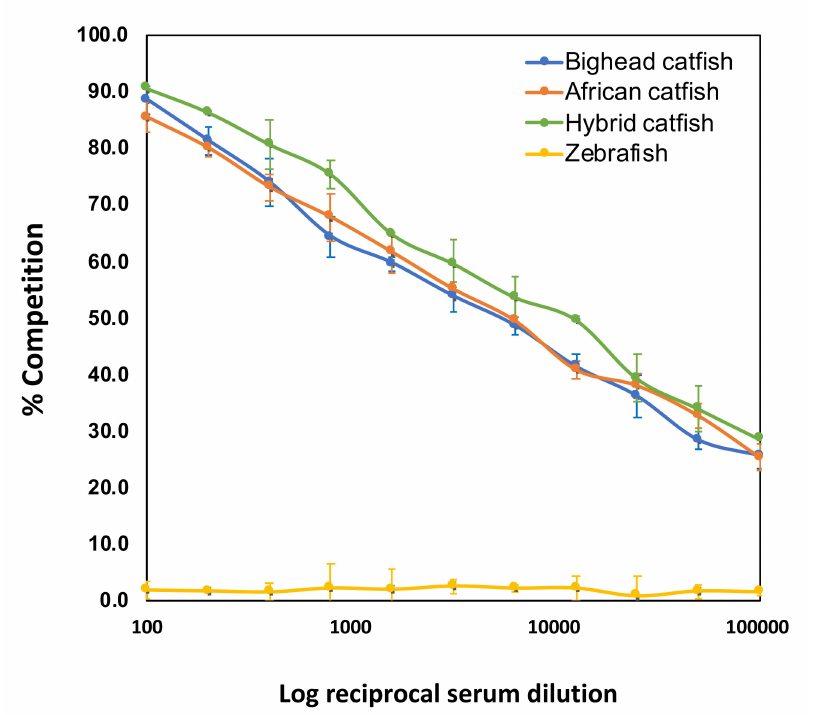
Figure 4. Specificity of the antigenic relatedness of the monoclonal antibody (mAb) specific to C µ 1 of the IgM heavy chain (IgMH) (IgMHC µ 1 mAb) within the catfish genus Clarias and between distinct species (zebrafish), as determined by indirect competition